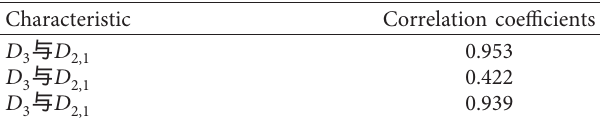
Table 6: Correlation coefficients between multiple systems. Characteristic